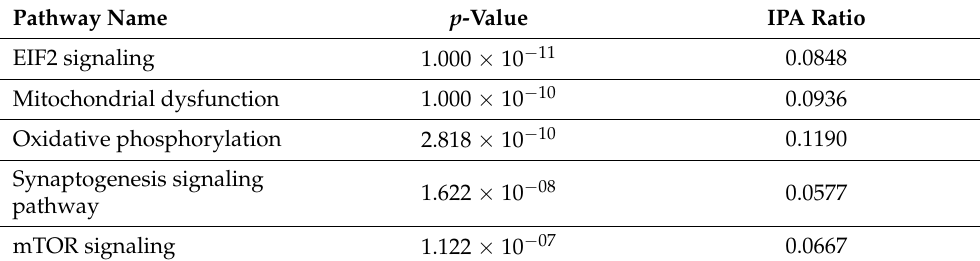
Table 4. Top 5 canonical pathways affected by TAC treatment, as highlighted by IPA.